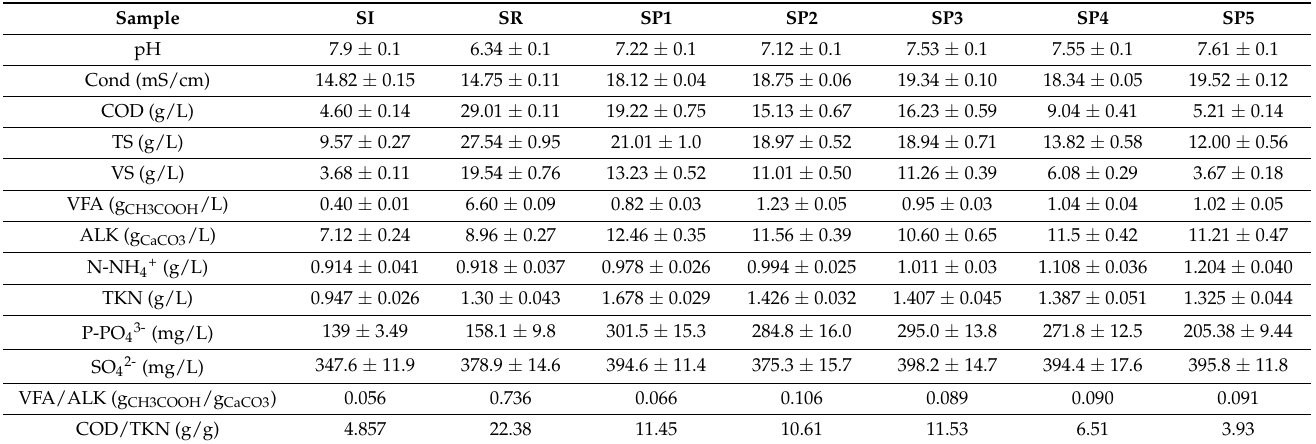
Table 4. Characteristics of samples at the end of BMP